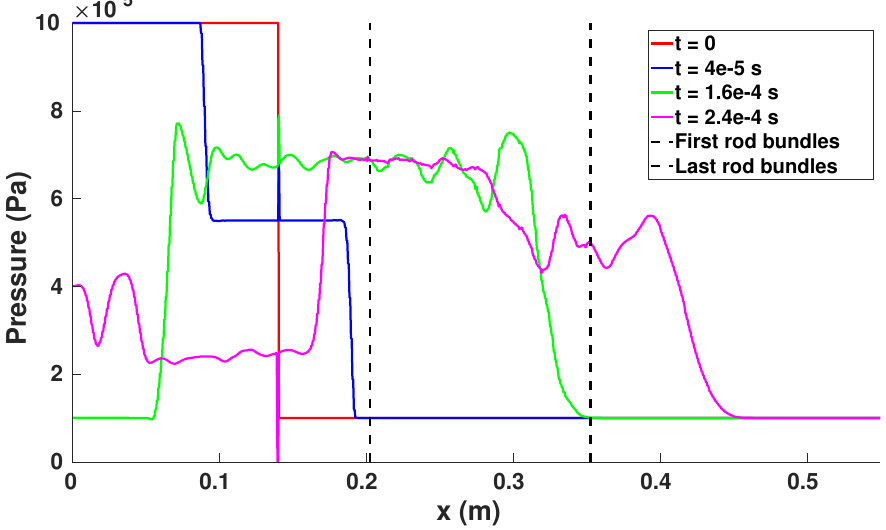
Figure 5. Reference pressure along the medium horizontal axis.